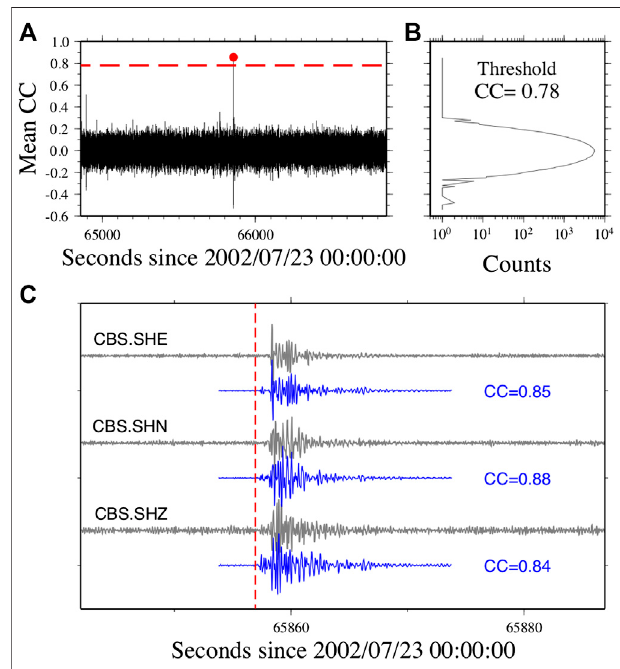
FIGURE 2 | (A) Mean correlation coef fi cients between the template seismograms and the continuous waveforms in (C) . The red dashed line indicates the mean CC threshold (0.78) for detection, the black line the mean CC value, and the red point the mean CC value of a positive detection. (B) Histogram of the mean CC in (A) . (C) Template seismograms (blue traces) and continuous waveforms (gray traces). The red dashed line indicates the origin time of a positive detection and the template earthquake. The channel name and CC value are given on the left- and right-hand sides of each trace,